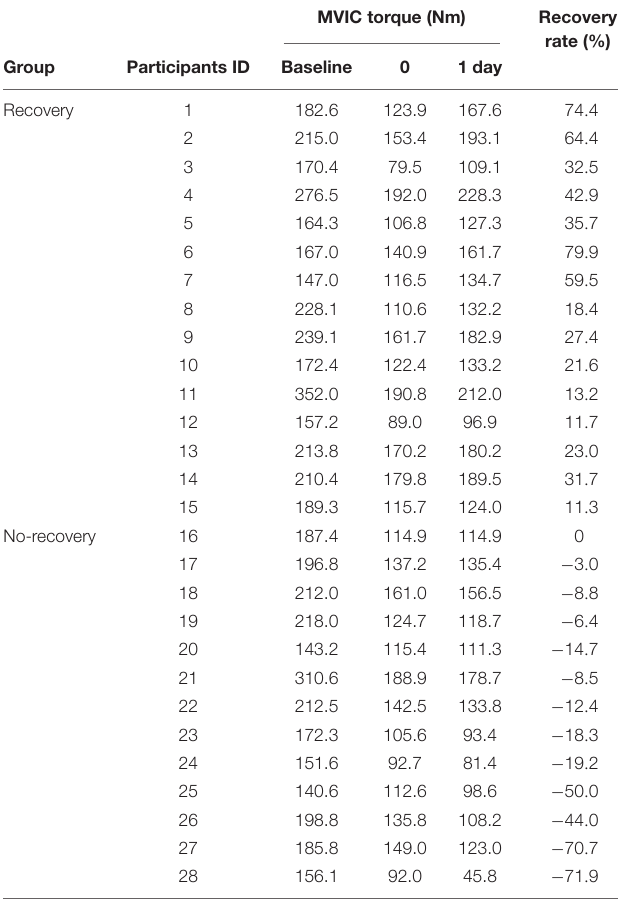
TABLE 1 | Maximal voluntary isometric contraction (MVIC) torque at baseline, immediately (0) and 1 day after eccentric exercise of the knee extensors, and recovery rate from immediately to 1-day post-exercise ([MVIC torque at 1-day post-exercise − MVIC torque at immediately post-exercise]/[MVIC torque at baseline − MVIC torque at immediately post-exercise] × 100) for all participants ( n = 28).